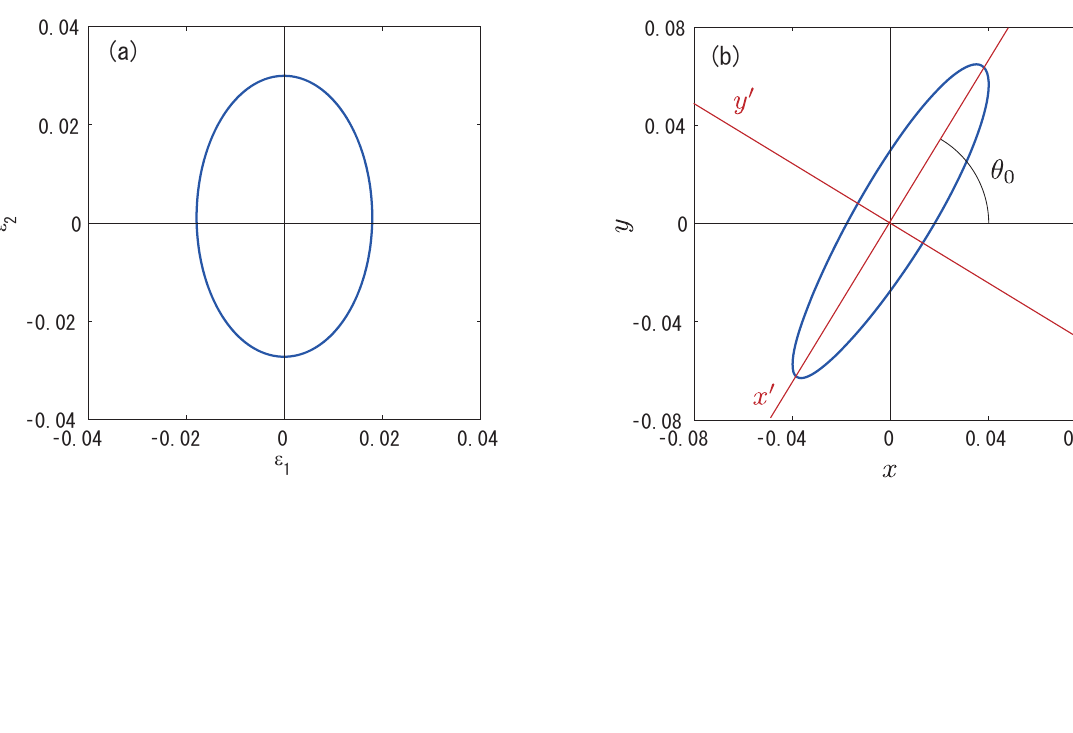
= 0 in Equation (14) 1 , 1